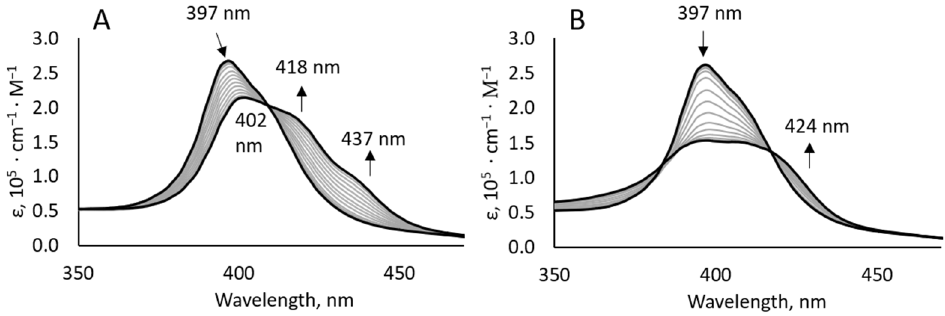
Figure 3. Absorption spectra of titration of bis–ZnOEP (3.2 × 10 − 6 M, CH 2 Cl 2 , 296 K) with ( A ) ( R , R )- cycHC[6] from 0 to 2000 equivalents and with ( B ) ( R , R )- cycHC[8] from 0 to 2000